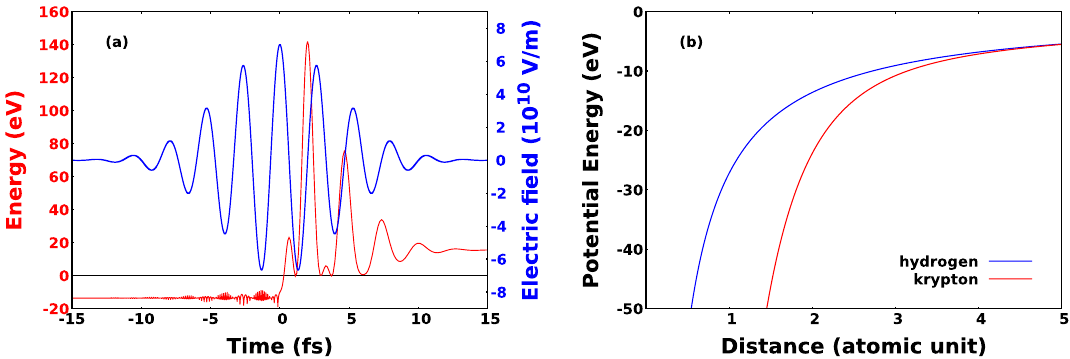
Figure 5. Electron energy and incident electric field of the ultrashort laser pulse as a function of time ( a ). The 10 14 W / cm 2 . The time of ionisation is the moment when the energy of electron applied laser intensity is 6.5 × reaches 0 eV at the first time. Atomic potentials of hydrogen and krypton atoms ( b ) defined in Eqs. (12)-(13).